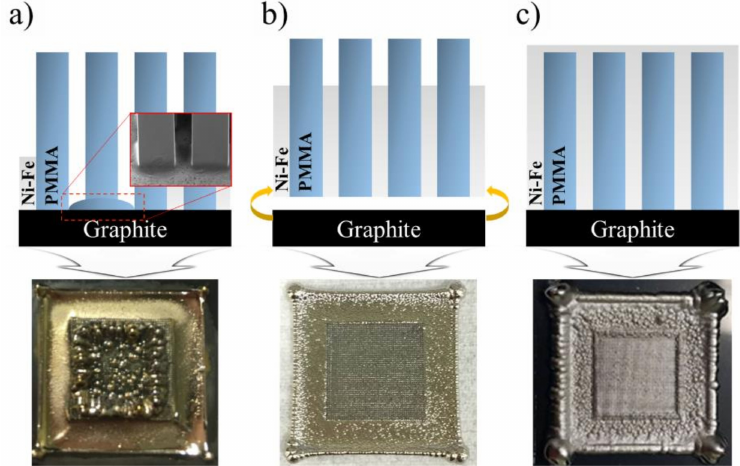
Figure 4. Optimization of Ni-Fe electroforming process. ( a ) Ununiform electroforming layer caused by PMMA residual on bottom; ( b ) Detachment from the substrate due to the weak adhesion; ( c ) Successful electroforming without ununiform layer and detachment.